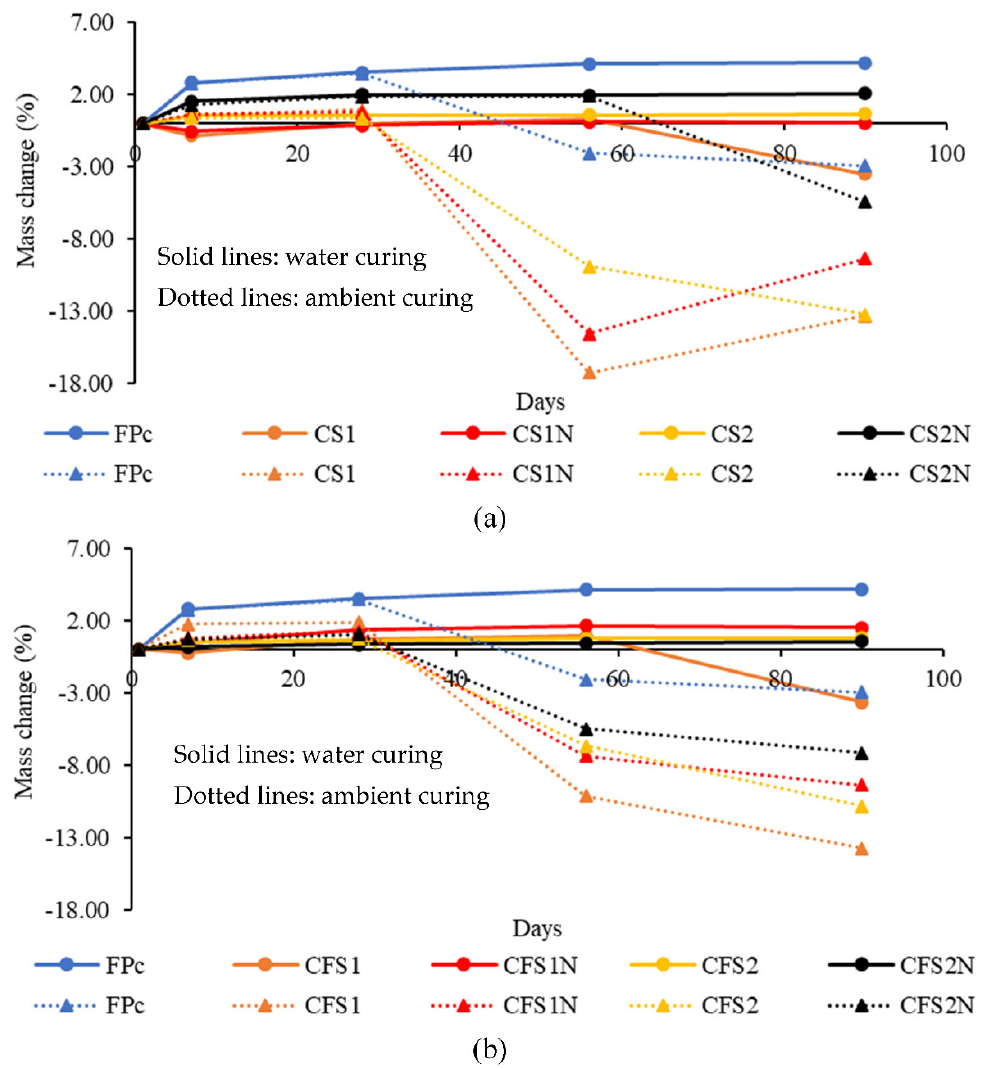
Figure 10. ( a ) Influence of the binary combinations of SCMs on mass change. ( b ) Influence of the ternary combinations of SCMs on mass change.